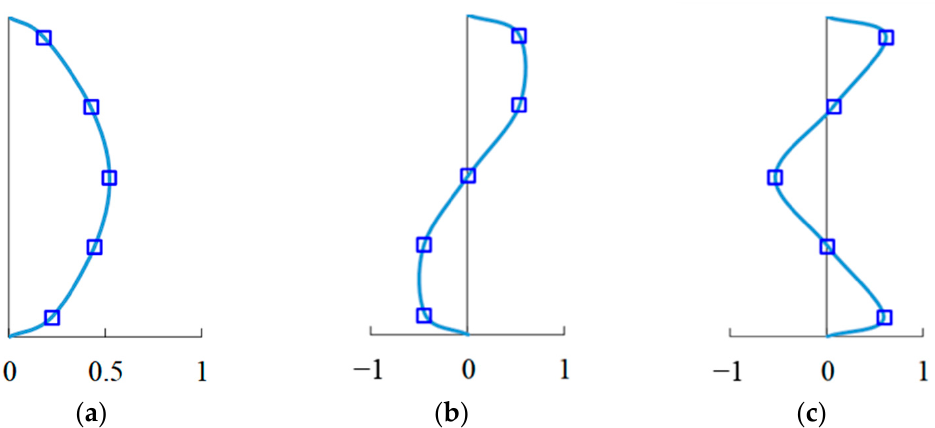
Figure 17. Identification results of vibration modes of the main beam. ( a ) 1st order; ( b ) 2nd order; ( c ) 3rd order.